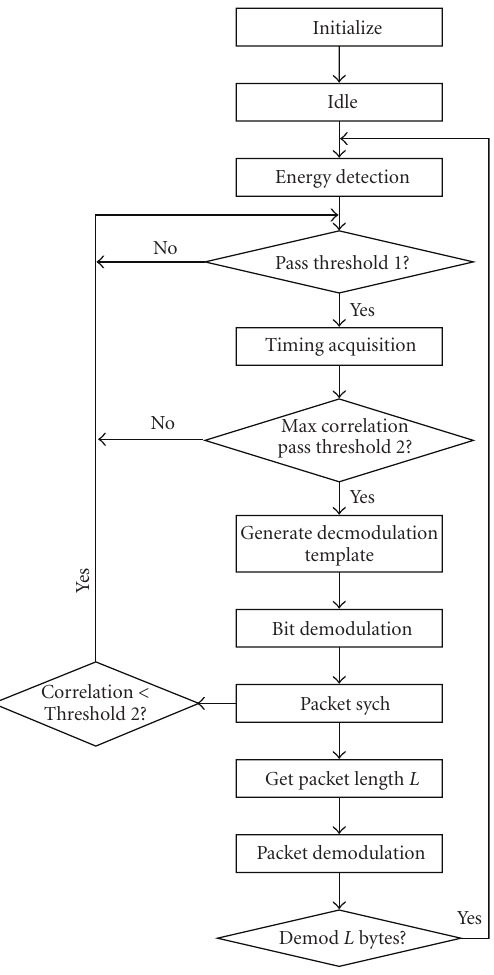
Figure 4: Receiver physical layer processing